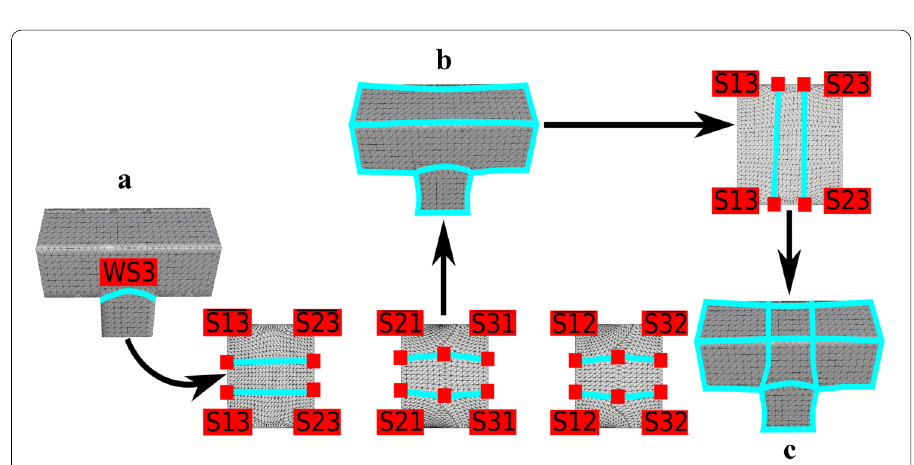
Fig. 9 Quadrilateral layout arcs generation. a We keep W S 3 passing through all cutting feature points. Into each relevant U k partial line inverse mapping is performed using points in C , D and possibly in O . (b) Curves in the physical space with supplementary boundary curves. Other arcs are determined to have a valid quadrilateral layout or cuboid configuration ( c